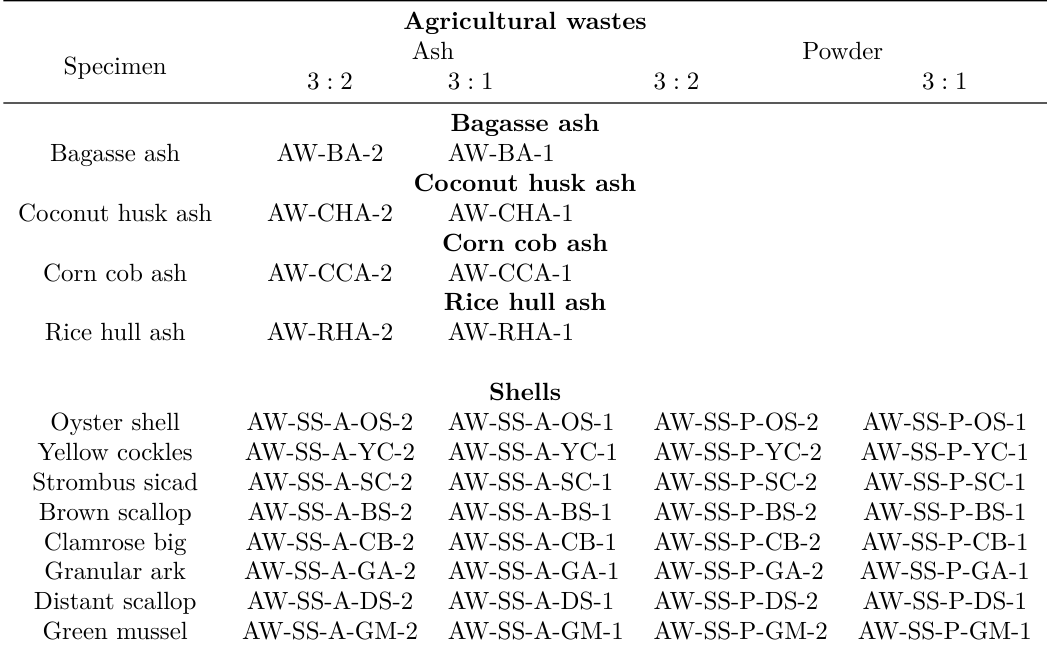
Table 2. Agricultural wastes as candidate materials in reducing DO